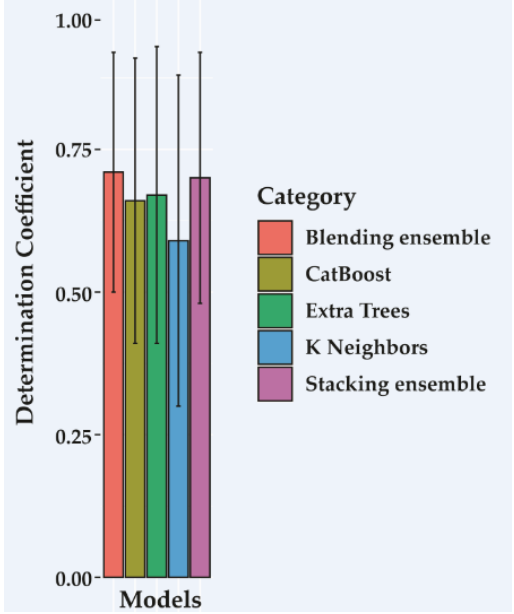
Figure 1. Average determination coefficient values of employed models.